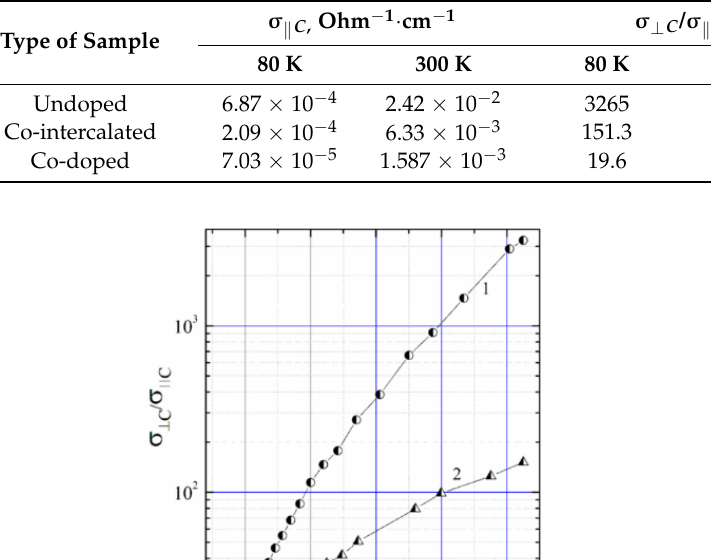
Table 3. Parameters of electrical conductivity anisotropy for different samples of n -type InSe.